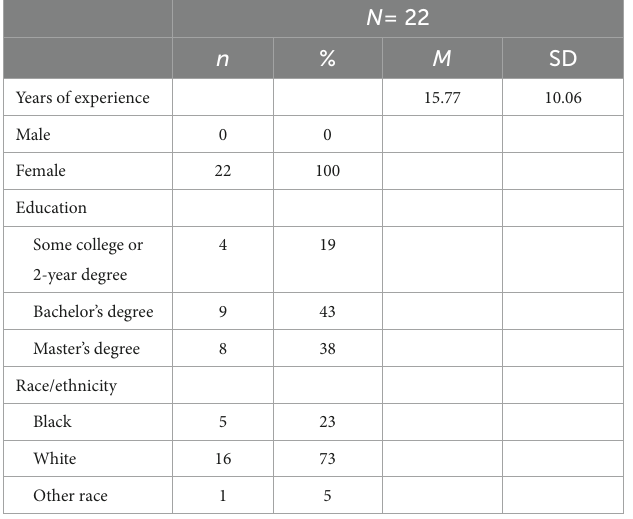
TABLE 3 Served educators’ socio-demographic